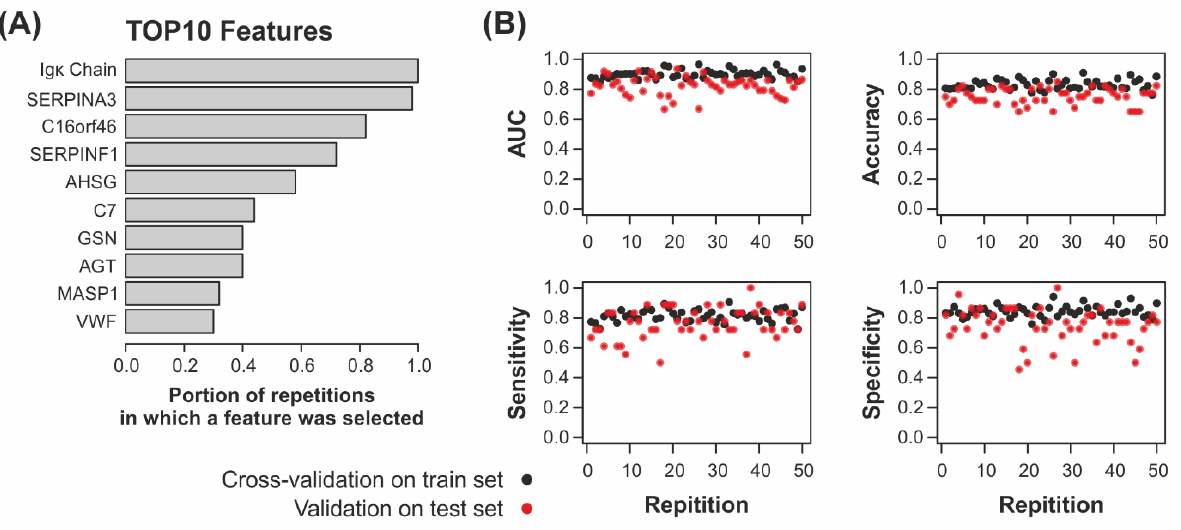
Different p -value thresholds were assessed for feature selection and plotted against the respective ten-times-repeated 10-fold-cross-validated AUCs. ( B ) Receiver operating characteristic (ROC) curves for the best-performing random forest classifiers (AC vs. COPD: p -value threshold = 0.2; AC with COPD vs. COPD: no p -value threshold). ( C ) Feature importance plots illustrating the relative influence of individual proteins on multivariate classification models. Proteins represented by gene names (except Igκ Chain).